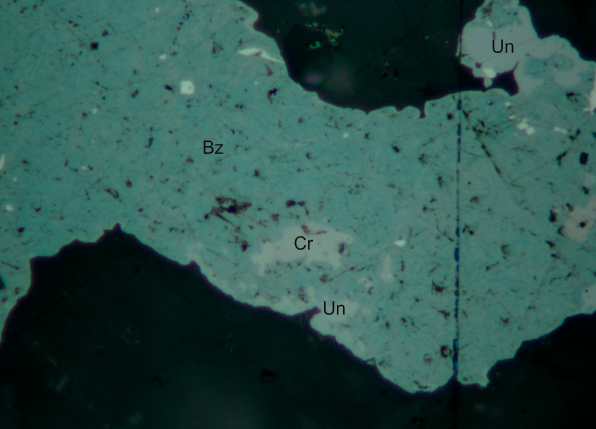
Figure 27. Anhedral brownish grey crookesite (Cr) grain embedded in berzelianite (Bz) in association with unnamed Cu − As selenide (Un). Reflected light, one polarizer. FOV 105 μ m. P ř íbram, a dump of shaft 16. Photo by P. Škácha.